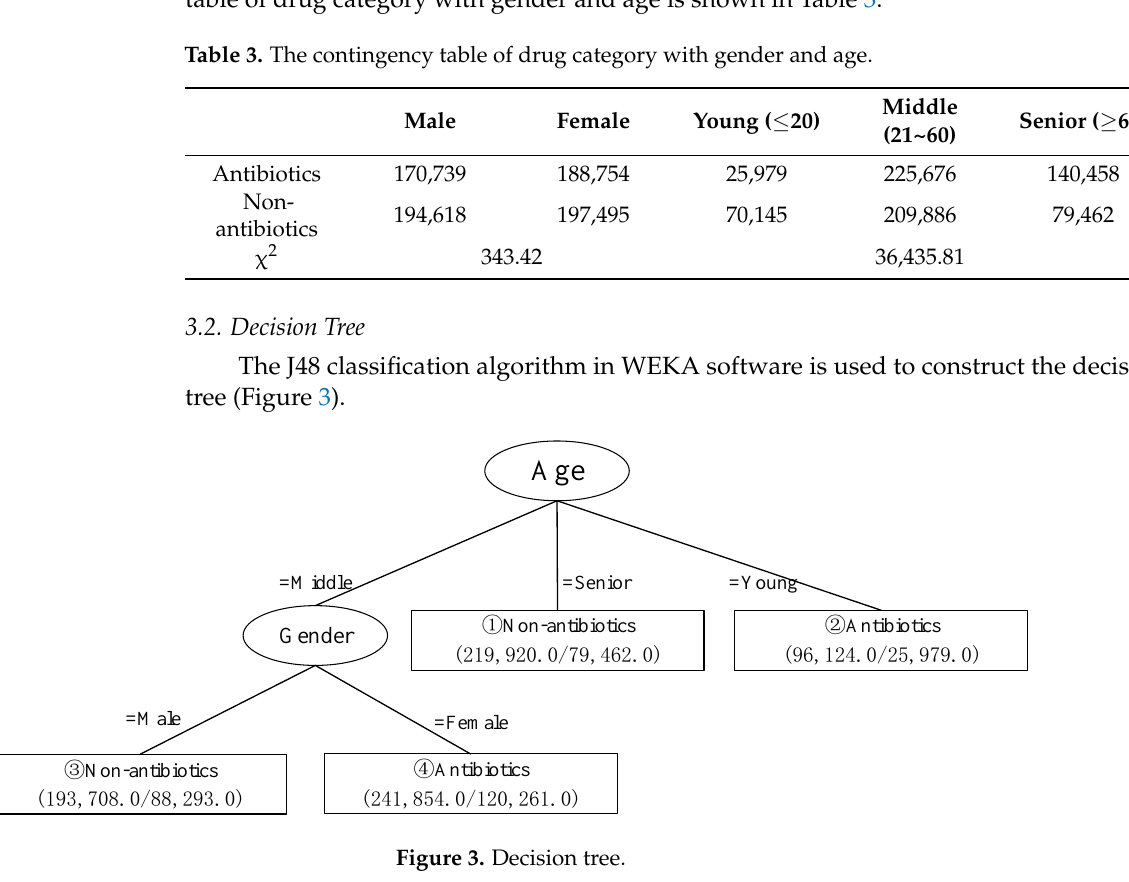
Table 4. Comparison of detection results of different stratification methods.